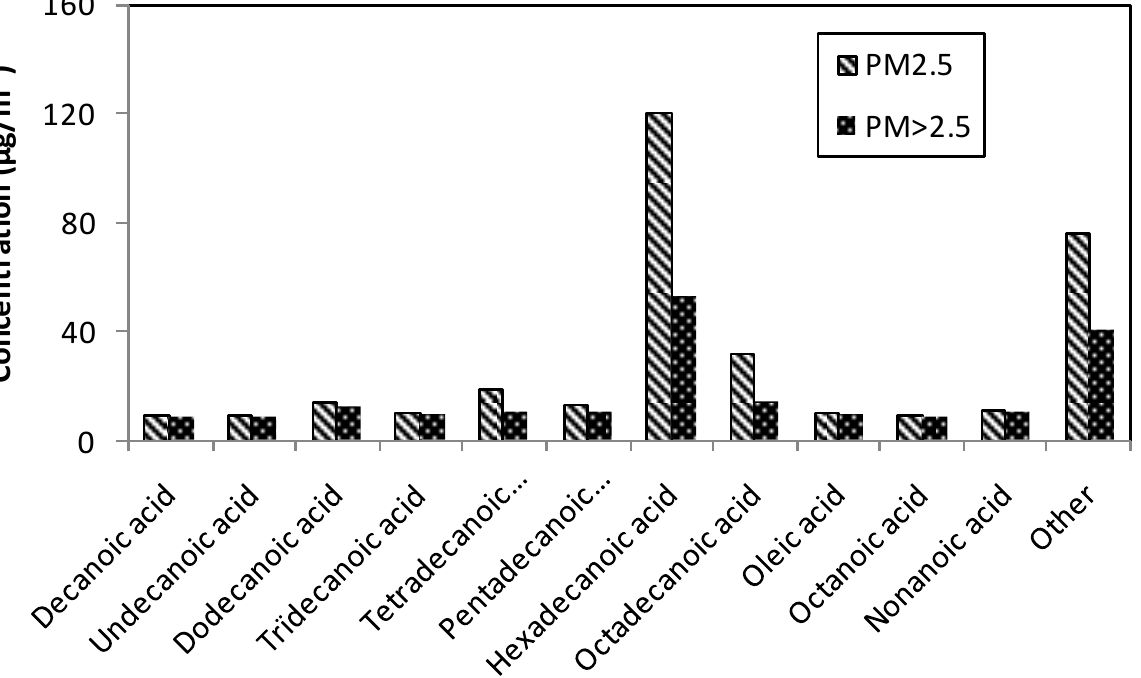
Figure 5. Carboxylic acids with a long aliphatic tail of two air pollution particulate matter. According to Oliveira et al. [110], fatty acids with even-numbered carbons of less than 20 carbons are considered to be derived from microbial activities and cooking meat. The ratio of oleic acid/stearic acid is a tool to identify aerosol aging [93]. Rogge et al. [111] suggested that when ratio of stearic acid/palmitic acid < 0.25, it originates from wood smoke and foliar vegetation combustion; between 0.25 and 0.5, it stems from car and diesel truck emissions; and is road dust when ranging from 0.5 to 1.0. In the present work, stearic acid/palmitic acid ratios were 0.26 in the two analyzed PM. Oleic acid/stearic acid ratios were 0.32 and 0.7 in PM 2.5 and PM >2.5 , respectively. Li et al. [93] reported a similar result in PM 2.5 according to the collection period in Beijing. In light of these results, fatty acids concentrations indicated mostly vehicle emissions and rejoined conclusions of previous